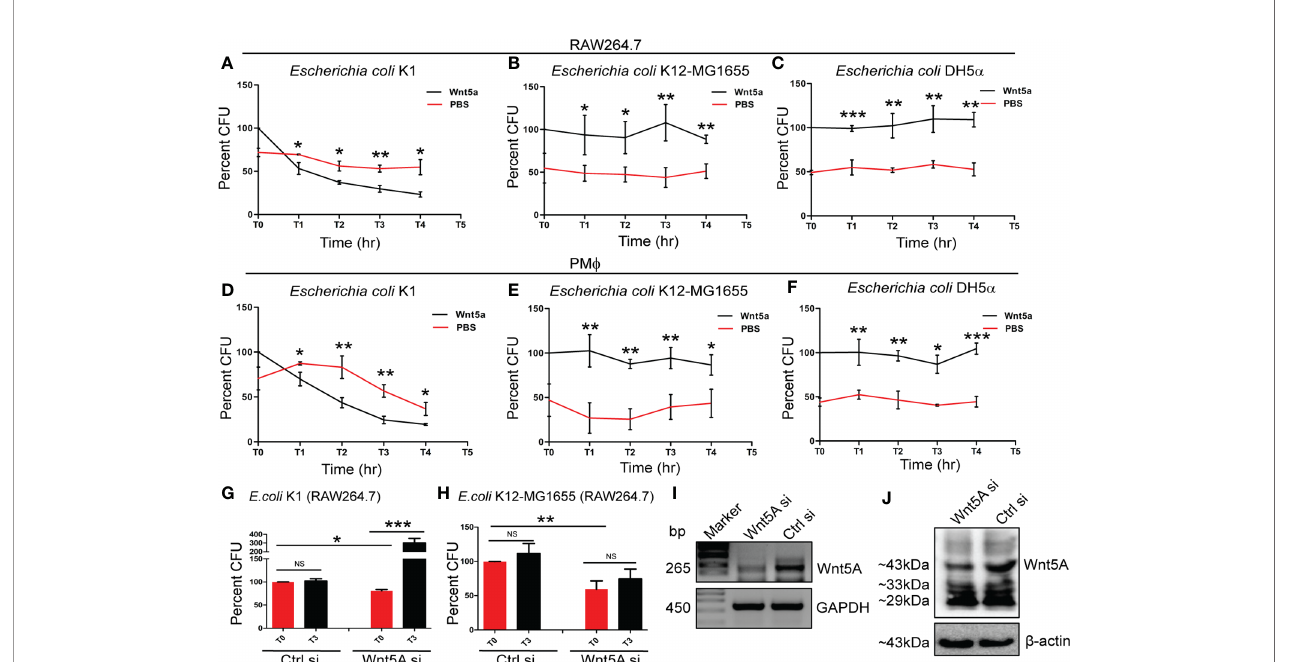
FIGURE 1 | Wnt5A signaling facilitates killing of pathogenic but not non-pathogenic E. coli . rWnt5A promoted intracellular killing of pathogenic bacterial strain E. coli K1 in both RAW264.7 (A) and peritoneal macrophages: PM f (D) as estimated by Colony Forming Units (CFU) (n = 3) at different time points (T1-T4), 1 h after infection (T0) at MOI: 10, as compared to corresponding control (PBS). rWnt5A did not promote killing of non-pathogenic bacterial strains E. coli K12-MG1655 (B, E) (n = 3) and E. coli DH5 a (C, F) (n = 3) as observed in both RAW264.7 and PM f in comparison to corresponding control. The CFU obtained at T0 for Wnt5A treated set is considered 100 and the values in other points are normalized accordingly. Wnt5A siRNA mediated decrease in endogenous Wnt5A expression resulted in decreased uptake of both E. coli K1 and E. coli K12-MG1655, yet promoted intracellular proliferation of pathogenic E. coli K1 (n = 3) but not non-pathogenic E. coli K12-MG1655 (n = 3) as depicted by CFU at T0 and T3 (G, H) . Depletion of Wnt5A expression by siRNA was con fi rmed by RT-PCR (I) and immunoblot analysis (J) in RAW264.7 cells. Data represented as mean ± SEM; * p ≤ 0.05, ** p ≤ 0.005, *** p ≤ 0.0005; NS, not signi fi cant. Wnt5Asi, Wnt5A siRNA; Crtlsi, control siRNA; Marker, DNA